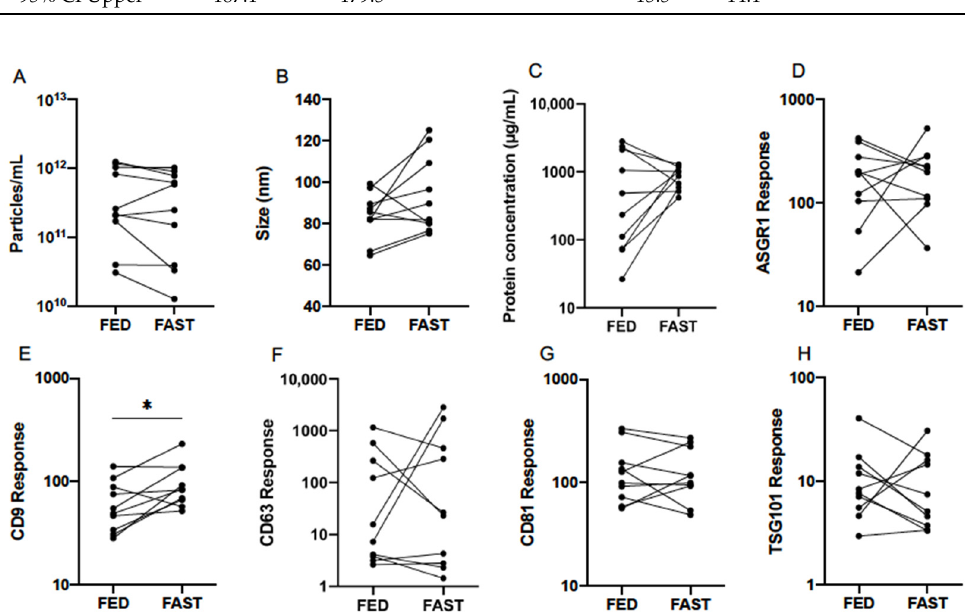
Figure 4. Effect of fed and fasted state on serum EV particle abundance ( A ), size ( B ), total protein concentration ( C ), and expression of EV-associated protein markers ( D – H ), quantified by nanoparticle tracking analysis (NTA), microBCA assay, and liquid chromatography mass spectrometry (LCMS) from healthy volunteers ( n = 10). Statistical analysis performed using paired t-tests. * p ≤ 0.05.